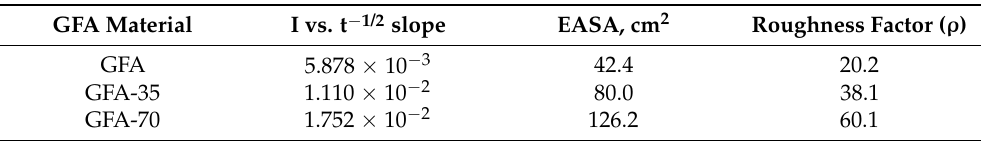
Table 5. Electroactive surface area (EASA) and roughness factor ( ρ ) calculated for the tested GFA ma- terials from chronoamperograms recorded at the tested materials in K 4 [Fe(CN) 6 ] (5 × 10 − 3 mol L − 1 in 0.1 mol L − 1 KCl) at the potential of 0.6 V vs.